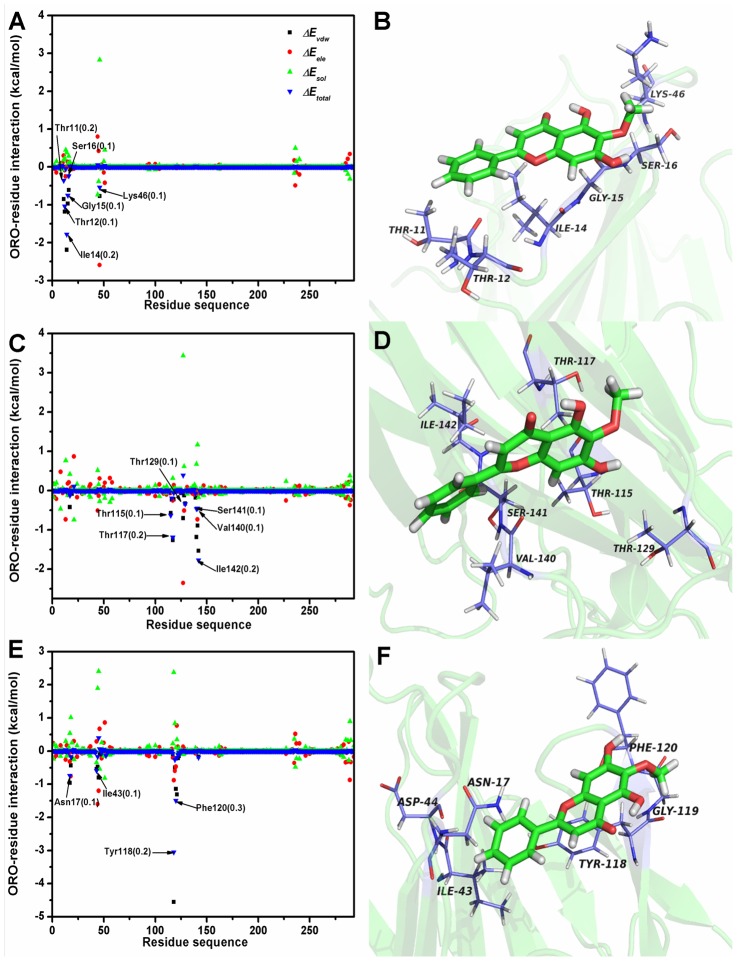
Energy contribution of van der Waals, electrostatic and solvation terms for the whole protein.(A), (B) Decomposition of the binding energy for each residue and predicted binding mode of ORO with the wild type protein. (C), (D) Decomposition of the binding energy for each residue and predicted binding mode of ORO with the T12A mutation. (E), (F) Decomposition of the binding energy for each residue and predicted binding mode of ORO with the I14A mutation. The error bars of ΔEtotal of the key residues have been given in the brackets.